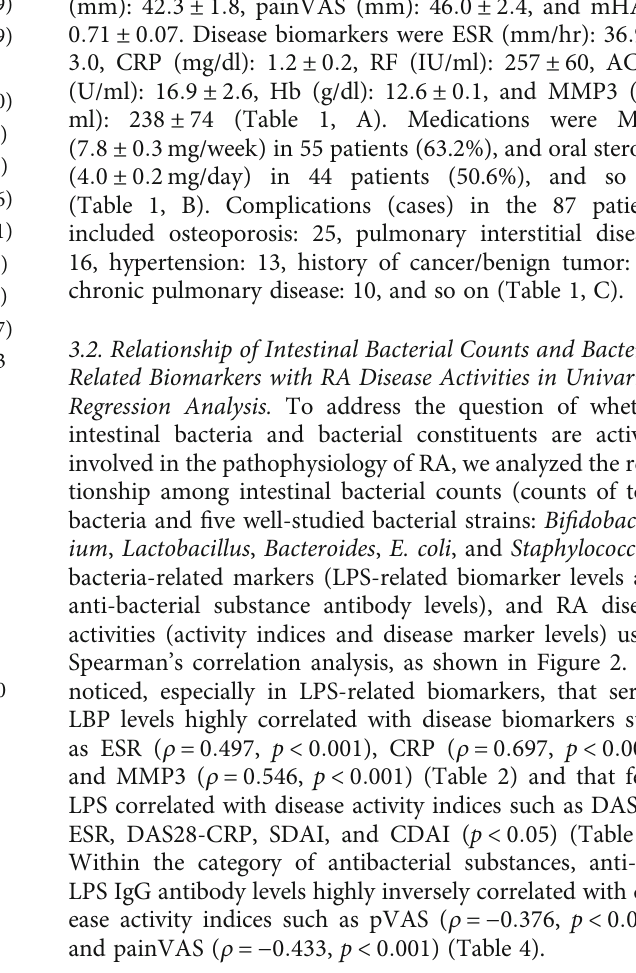
(Table 1, B). Complications (cases) in the 87 patients included osteoporosis: 25, pulmonary interstitial disease: 16, hypertension: 13, history of cancer/benign tumor: 12, chronic pulmonary disease: 10, and so on (Table 1, C).